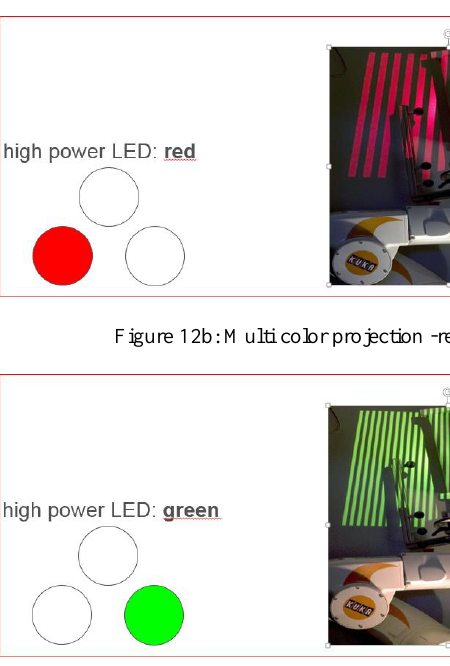
Figure 12c: Multi color projection - green